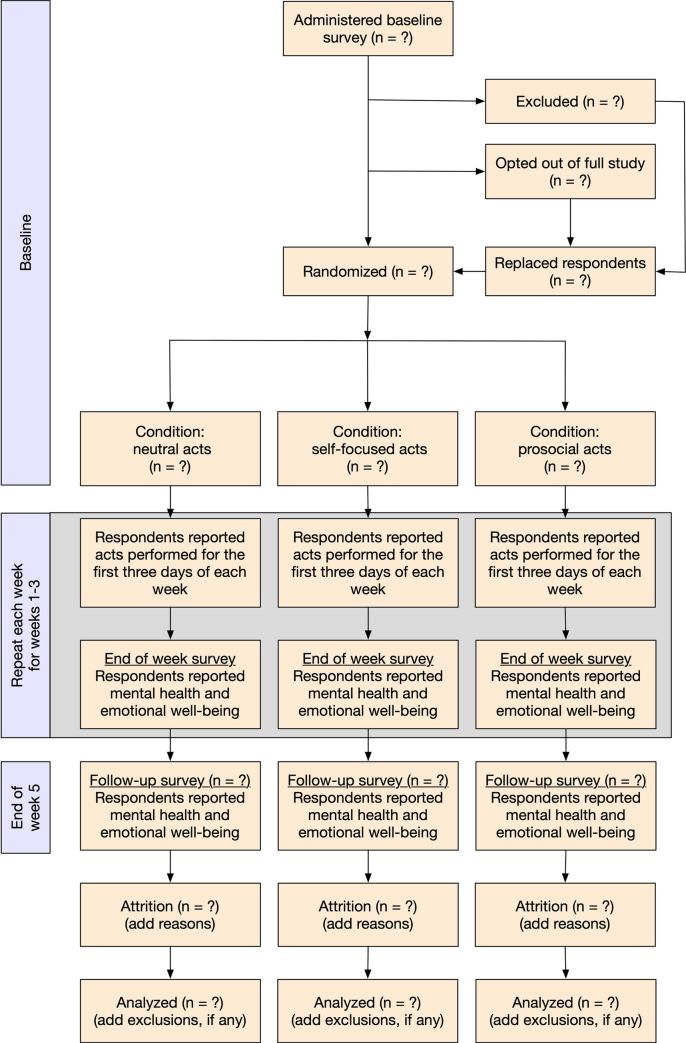
Flowchart of study procedures.